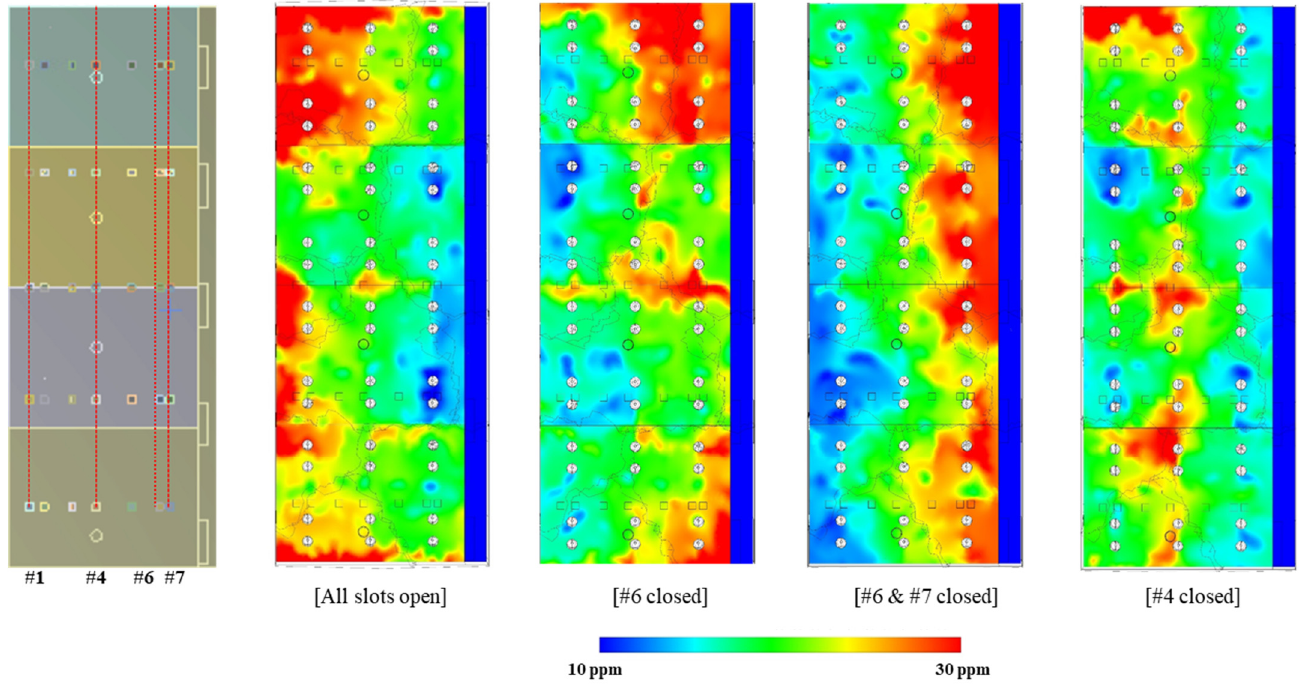
Figure 16. Distribution of ammonia concentration inside the experimental piglet house according to the opening conditions of ceiling slots .